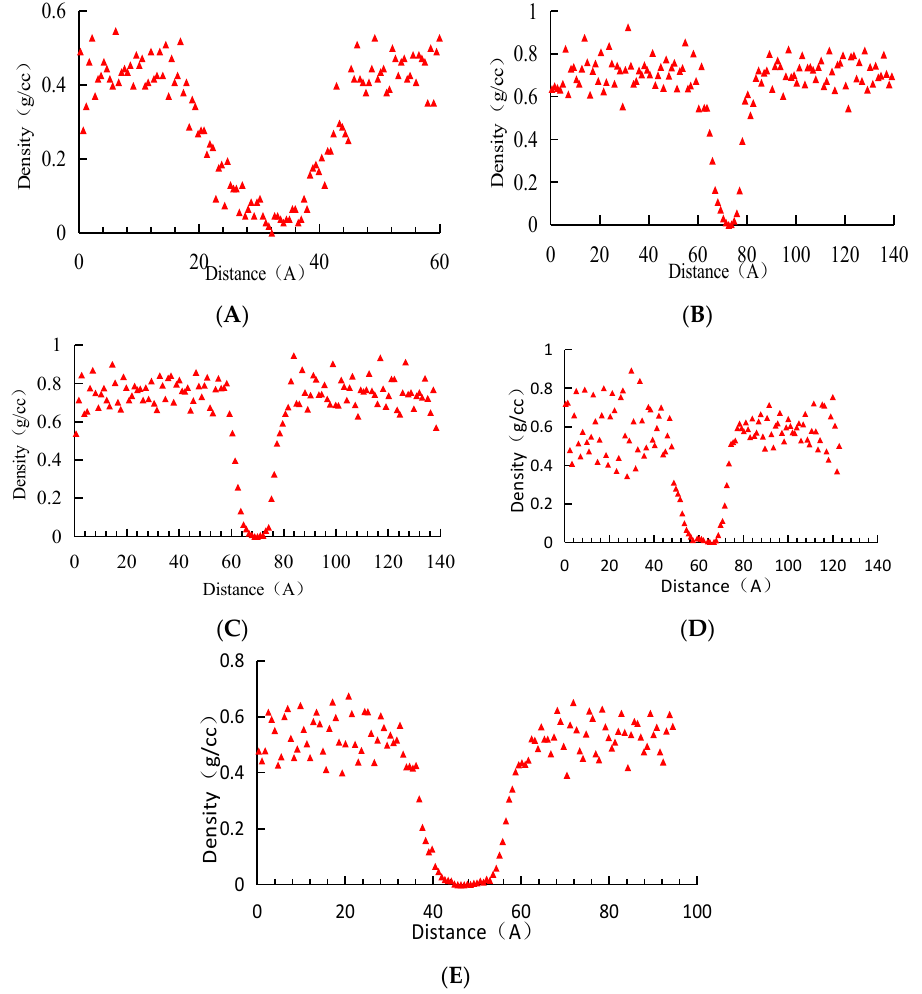
Figure 9. Density distribution of oil film molecules with different carbon chain lengths. ( A ) C 1 H 4 crude oil molecular density distribution. ( B ) C 2 H 6 crude oil molecular density distribution. ( C ) C 3 H 8 crude oil molecular density distribution. ( D ) C 4 H 10 crude oil molecular density distribution. ( E ) C 5 H 12 crude oil molecular density distribution.